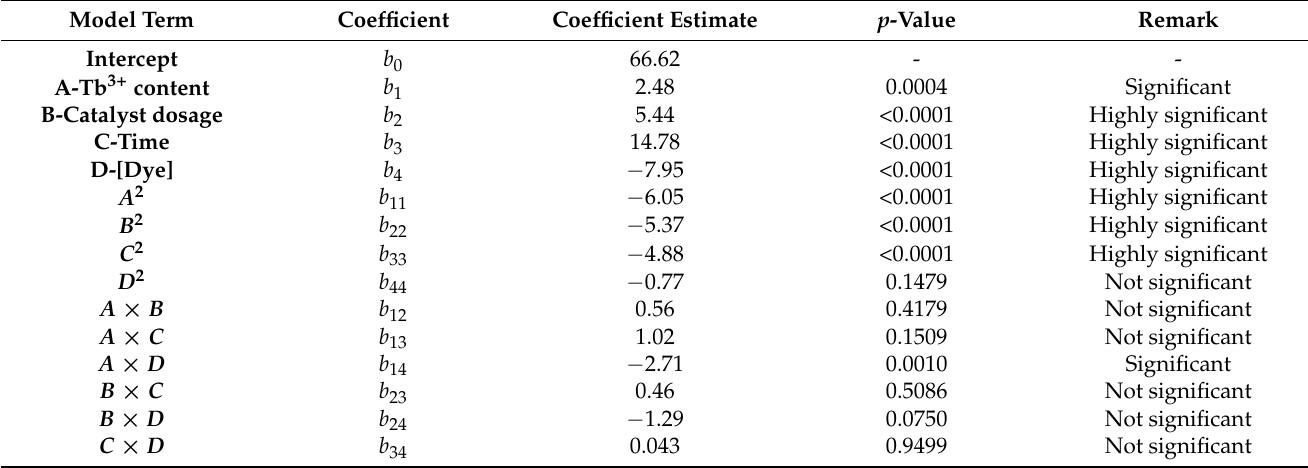
Table 7. Estimated model coefficients and p values for determining the importance of model